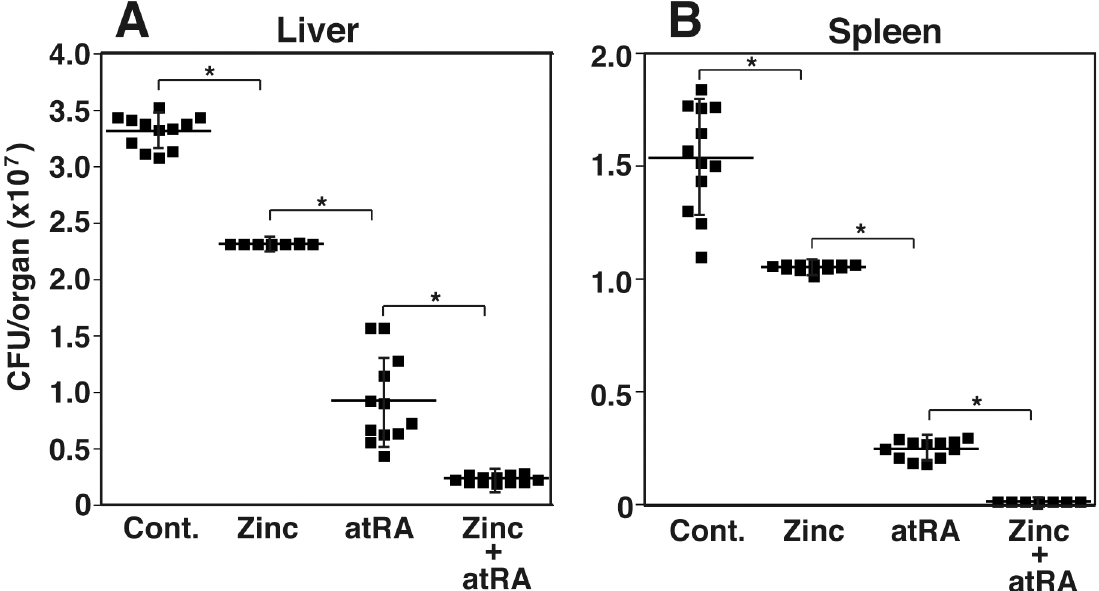
Fig 2. Number of L . monocytogenes in the target organs of Zn- and atRA-supplemented mice. Mice were injected intraperitoneally with Zn, atRA or a combination of both compounds. Twenty-four hours after the last dose, the mice were infected intravenously with 10 4 /100 μ l per mouse. CFU was measured in the liver and spleen 48 h after infection. The experiment was performed three times with four mice per group each time. Control mice received corn oil alone. Data are mean ± SD values of 12 mice per group. Statistically significant differences, compared with each group, are indicated by